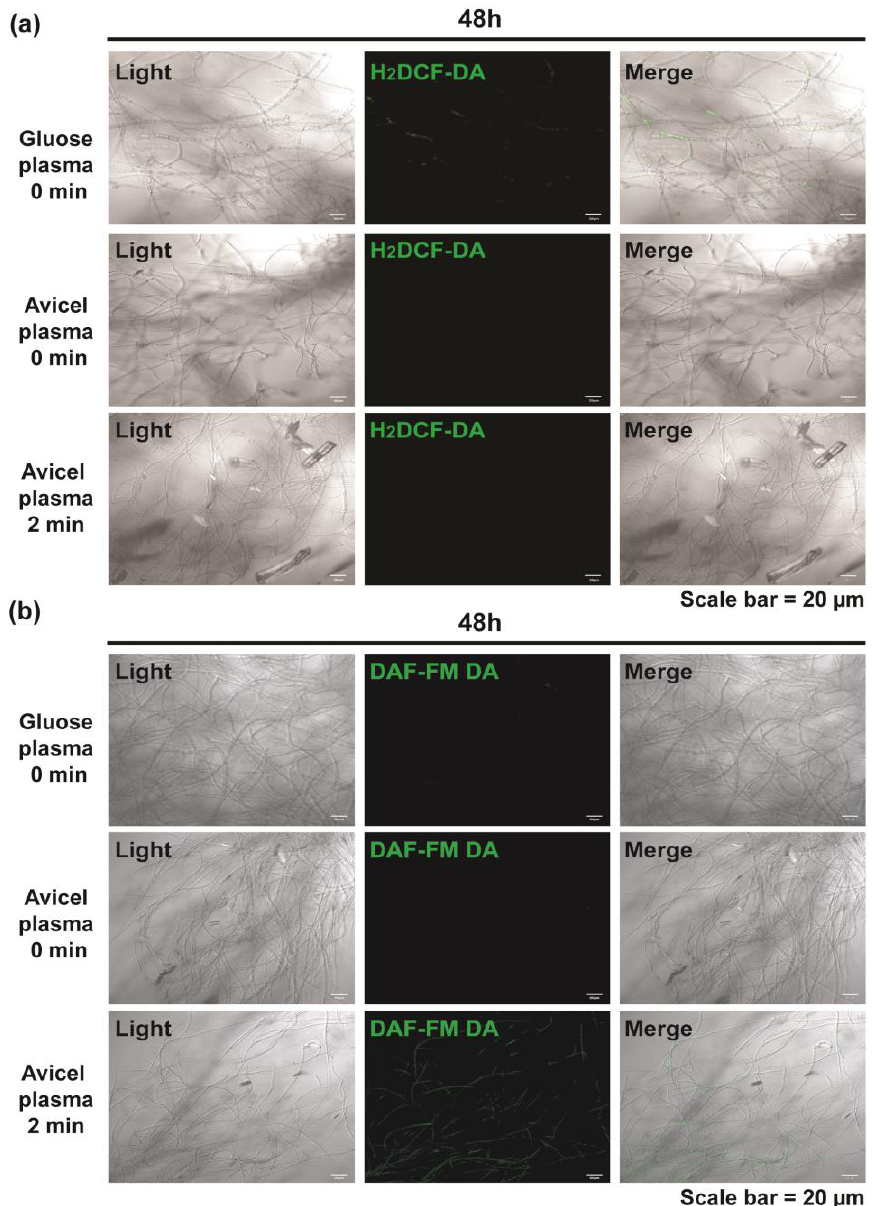
Figure 6. Intracellular ROS and NO stained with H 2 DCF-DA and DAF-FM DA, respectively, in fungal hyphae 48 h after plasma treatment for 0 min or 2 min. ( a ) Intracellular ROS detected using the fluorescent dye H 2 DCF-DA. ( b ) Intracellular NO detected using the fluorescent dye DAF-FM DA.